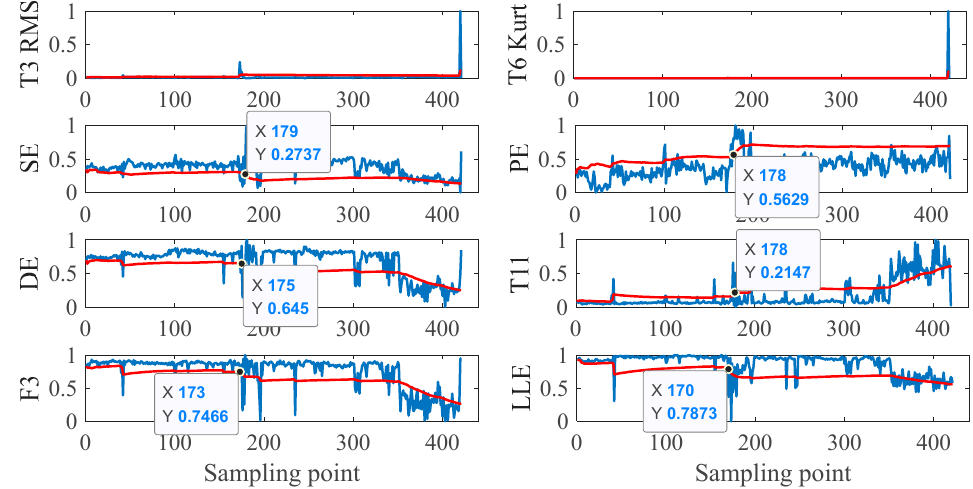
Figure 11. Check valve fault feature curve (blue curve) and status warning line (red curve).